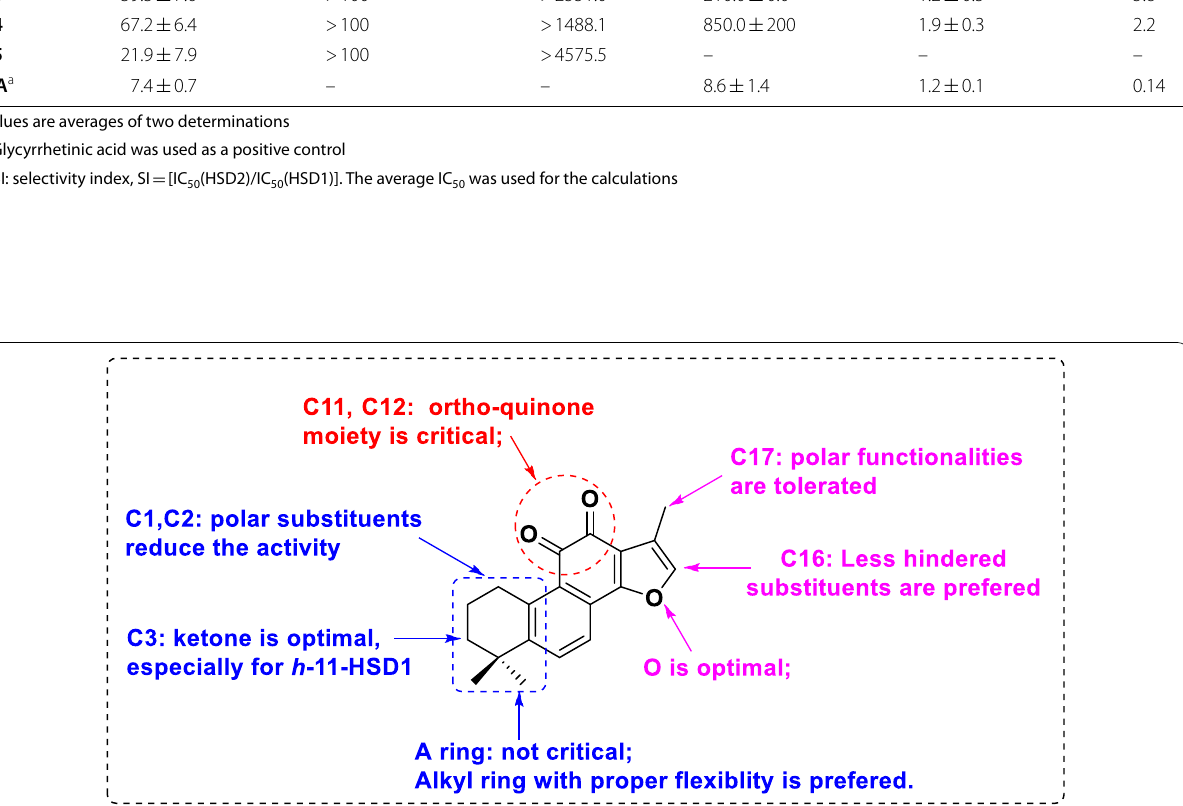
Fig. 3 Summary of SARs for selective inhibition against 11 β